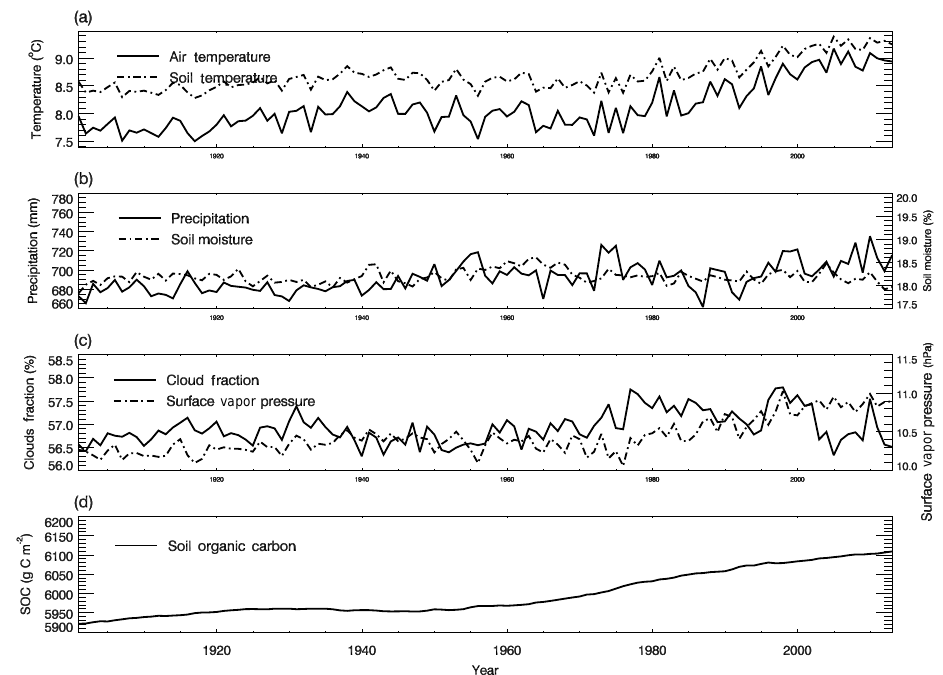
Figure 4. Historical global land surface (excluding the Antarctic area and ocean area) mean climate, and simulated global mean soil moisture, soil temperature and SOC for the period